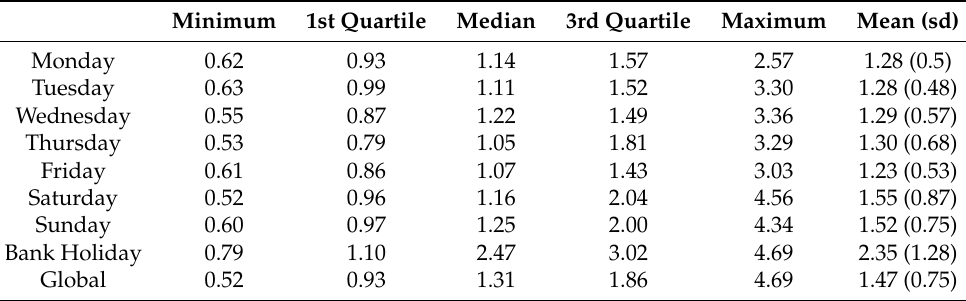
Table 15. Daily MAPE (in %) for RTE’s regression based model.